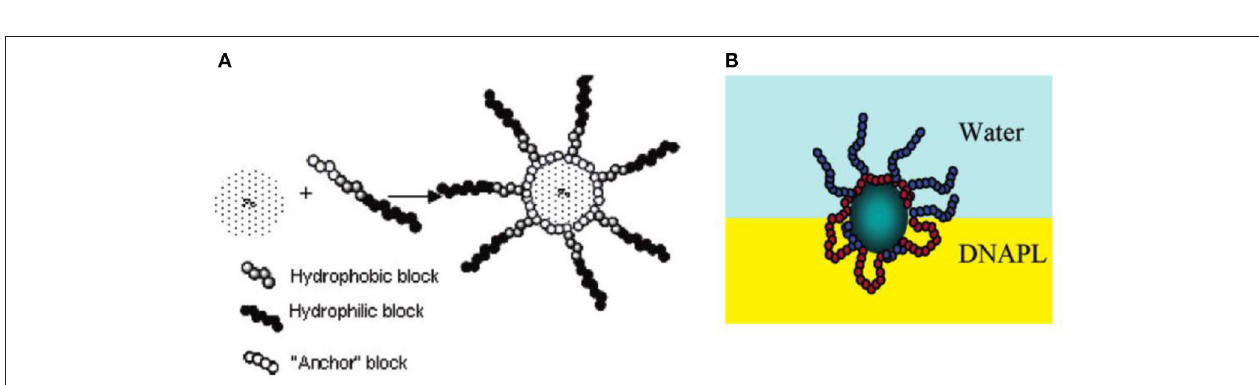
FIGURE 3 | Schematics representation of triblock copolymer-modified iron nanoparticles (A) and proposed chain rearrangement at oil/water interface (B) , the oil phase is toxic non-aqueous phase liquids (NAPL) ( Saleh et al., 2005a). Reprinted with permission from Saleh et al. (2005a). Copyright 2005 American Chemical Society.